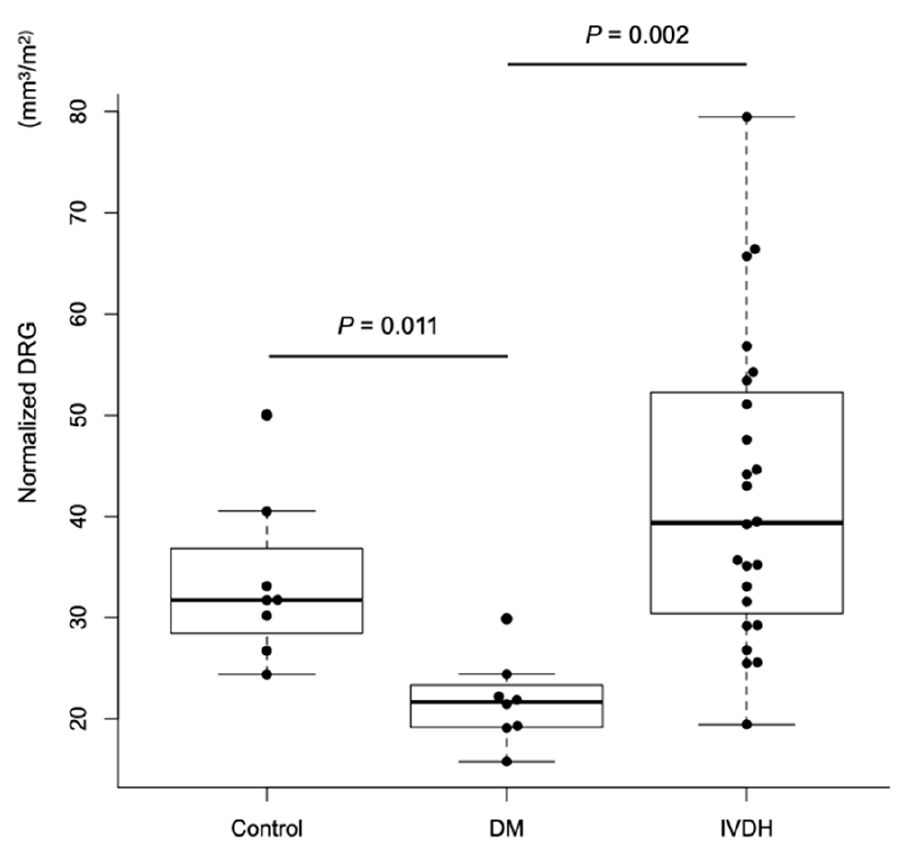
Figure 3. Comparison of the normalized mean dorsal root ganglion (DRG) volume among control, degenerative myelopathy (DM), and intervertebral disc herniation (IVDH) groups. The normalized mean DRG volume in DM group was lower than those in control and IVDH groups ( P = 0.011 and 0.002, respectively). Horizontal bars indicate medians within groups.